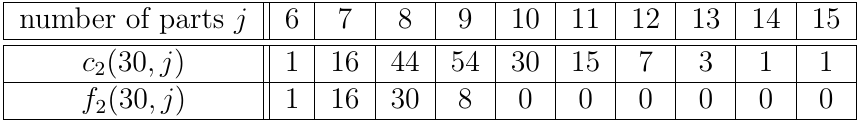
Table 8: Number of potentially (row c ical partitions of 30 with given number of parts j .